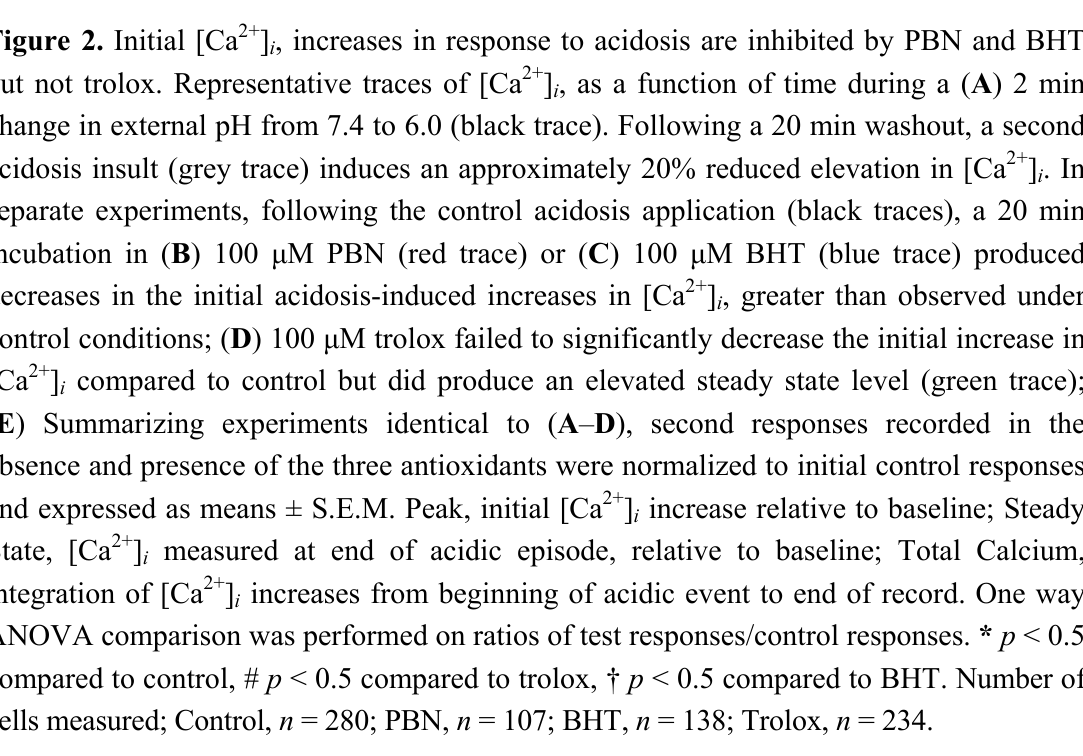
Figure 2. Initial [Ca 2+ ] , increases in response to acidosis are inhibited by PBN and BHT i , as a function of time during a ( A ) 2 min but not trolox. Representative traces of [Ca 2+ ] i change in external pH from 7.4 to 6.0 (black trace). Following a 20 min washout, a second acidosis insult (grey trace) induces an approximately 20% reduced elevation in [Ca 2+ ] . In i separate experiments, following the control acidosis application (black traces), a 20